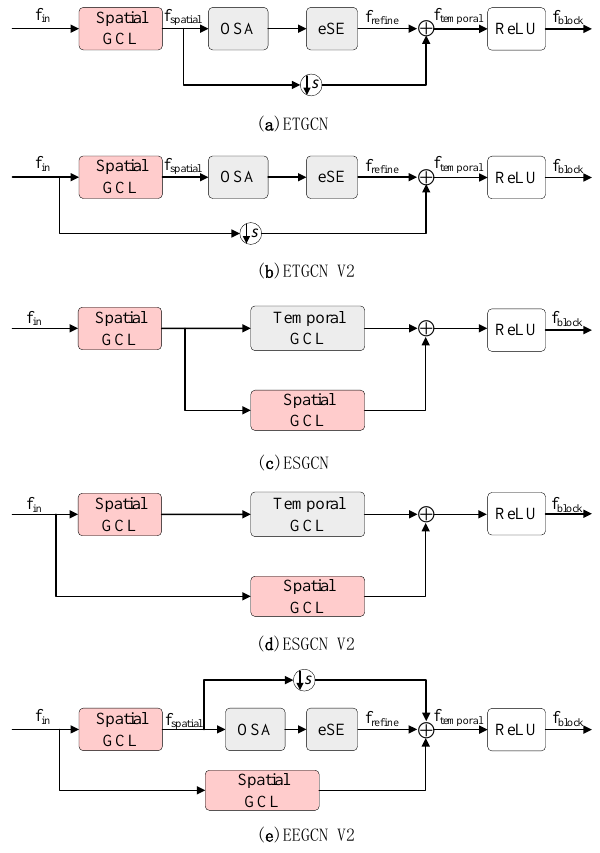
Figure 6. Various variants of our proposed method.